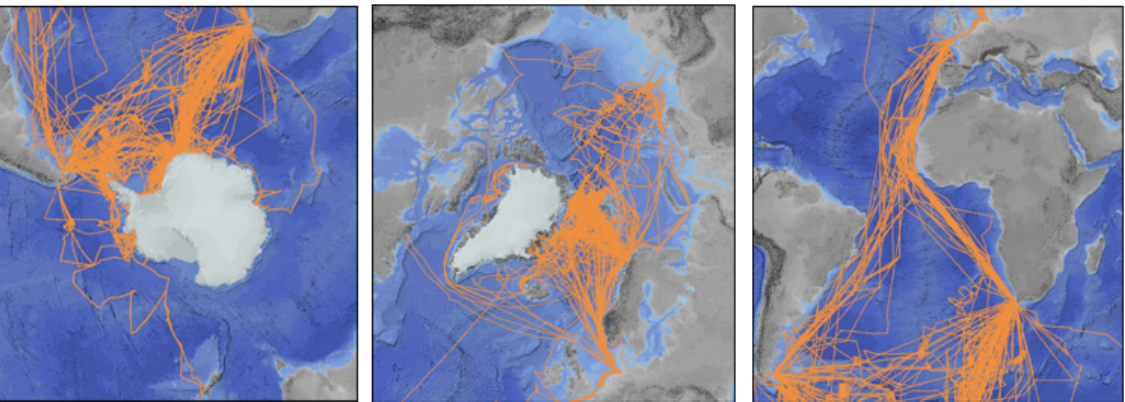
Figure 4: Operation areas in the Antarctic, Artic and the Atlantic transfer